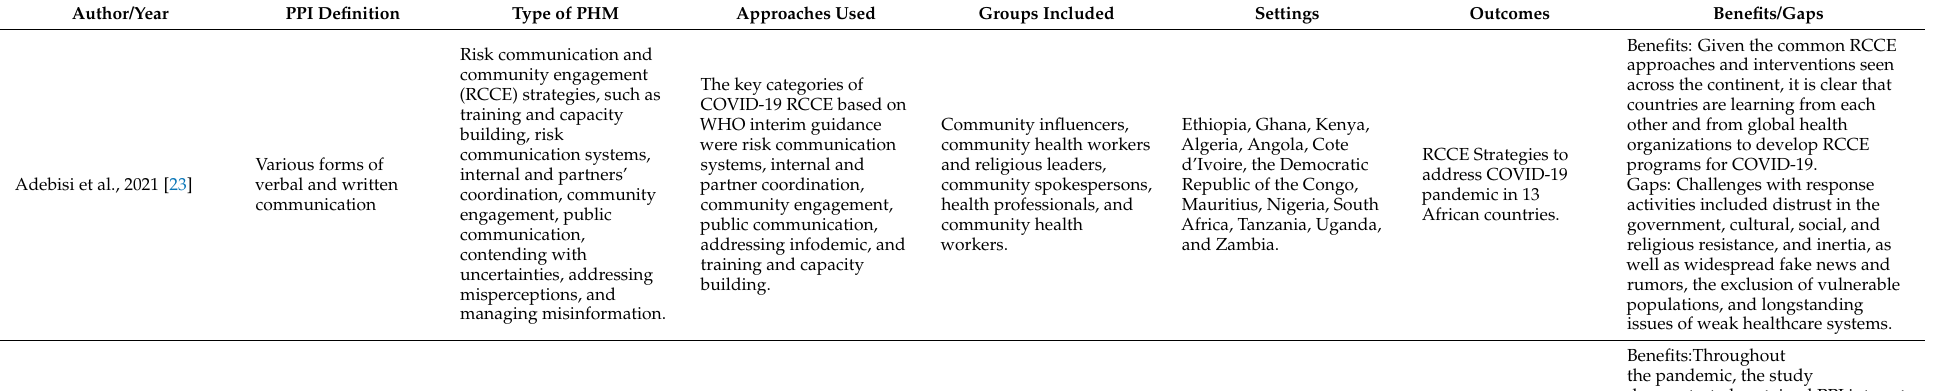
Table 3. Overview of quantitative and qualitative